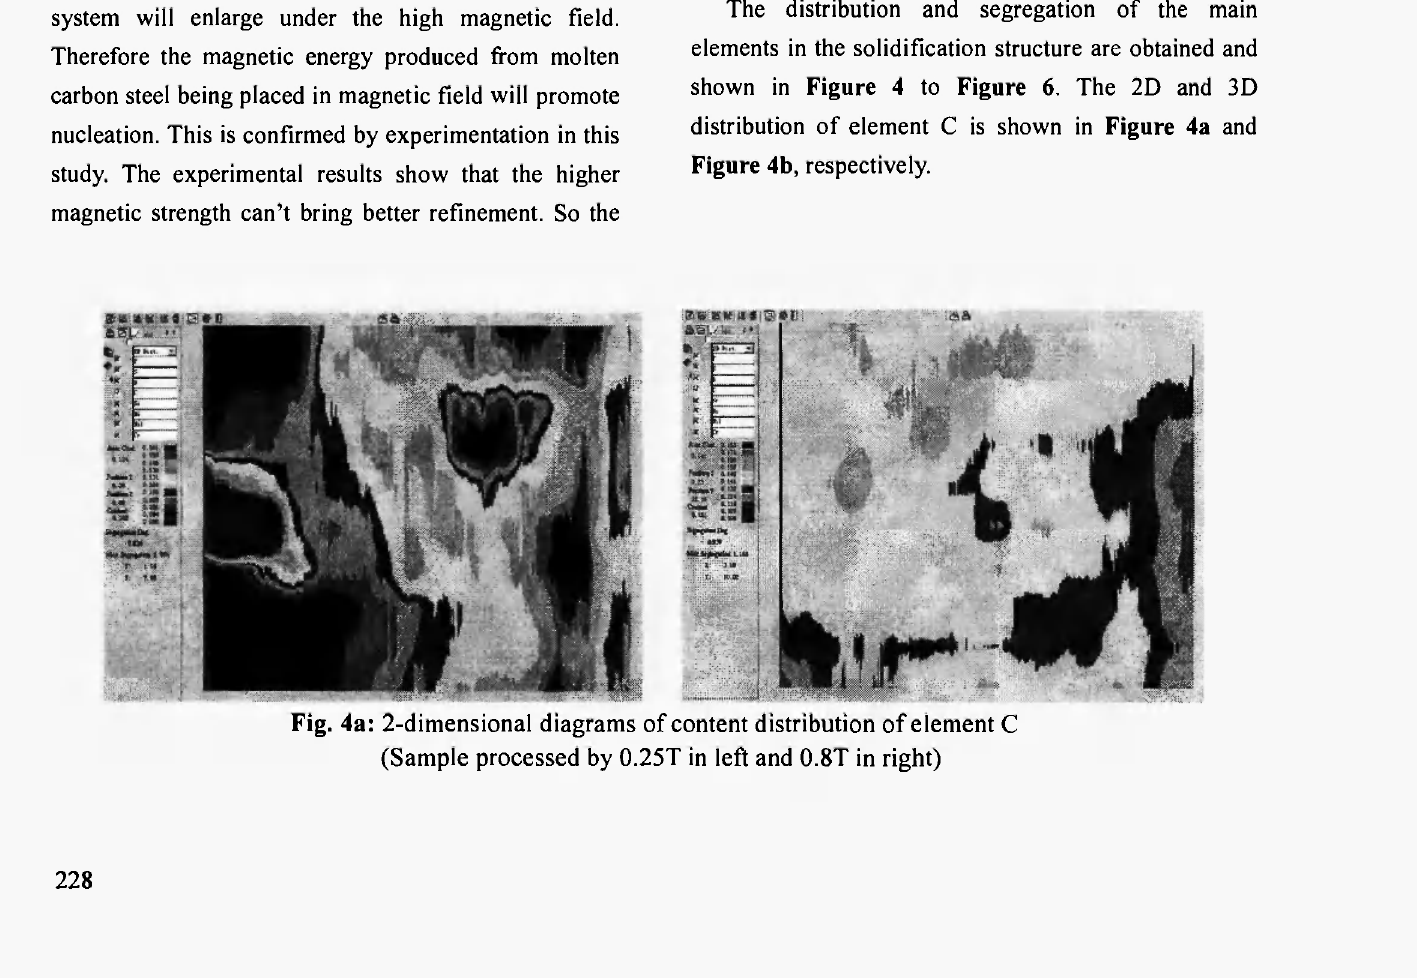
Fig. 4a: 2-dimensional diagrams of content distribution of element C (Sample processed by 0. 25T in left and 0.8T in